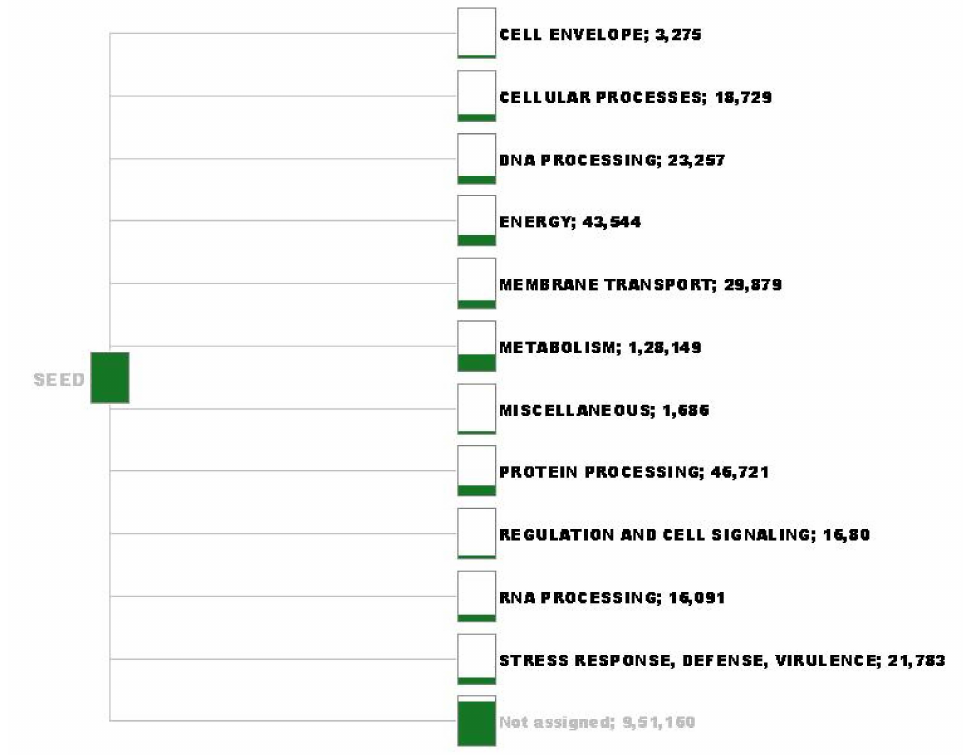
Figure 6. SEED analysis for categorization and identification of major enzyme groups that appear in ZBNF